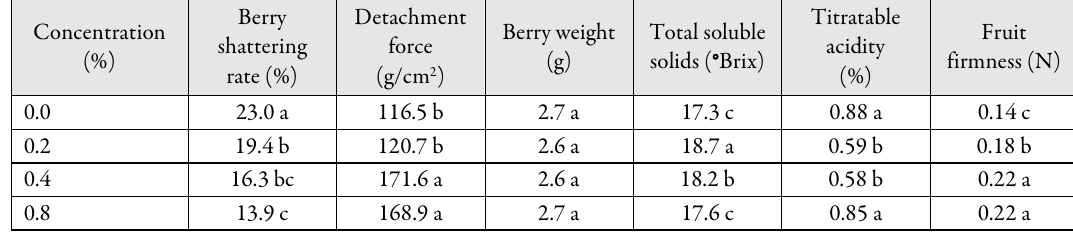
The same letters denote no significant difference at p < 0.05. Table 2. Correlation matrix for study variables Pearson correlation Berry shattering rate